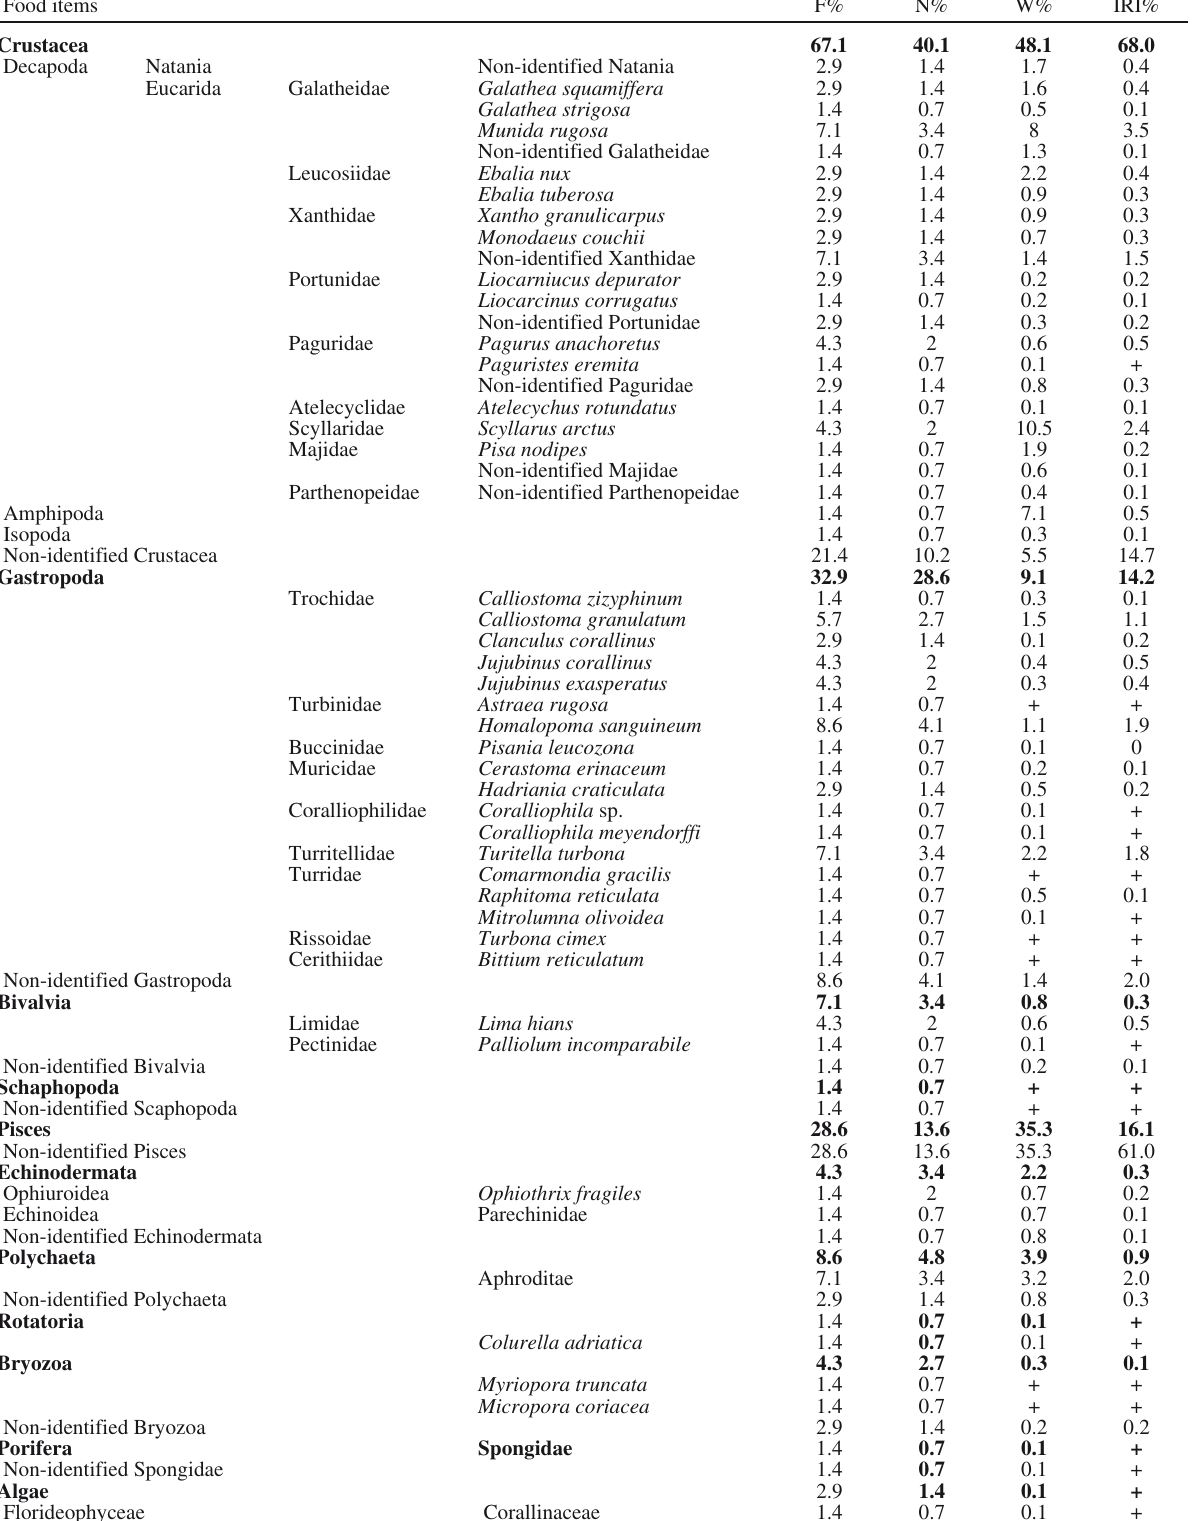
Table 3. – Labrus mixtus. Percent frequency of occurrence (%F), percent of total number (%N), percent of total weight (%W) and percent index of relative importance (%IRI) for food items. (+) indicates all values <0.1%. Food items F%